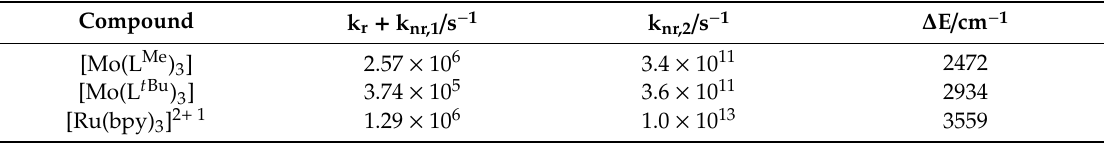
Table 4. Results from fits with Equation (6) to the temperature-dependent luminescence lifetime data in Figure 4.